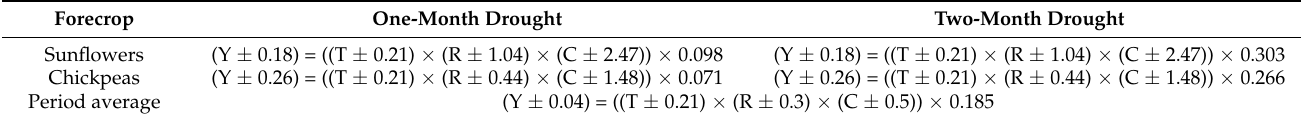
Table 10. Winter wheat productivity model depending on the type of drought and forecrop,